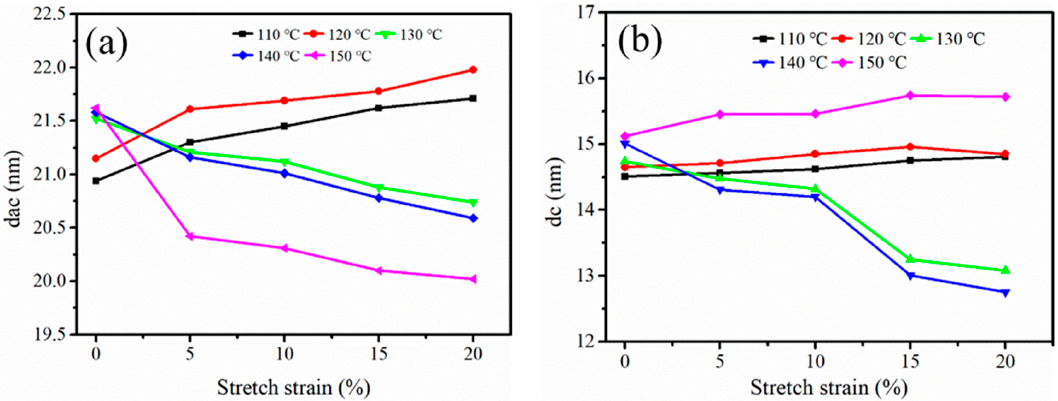
Figure 7. The d ac and d c of the iPP sheet after stretching at different temperatures.